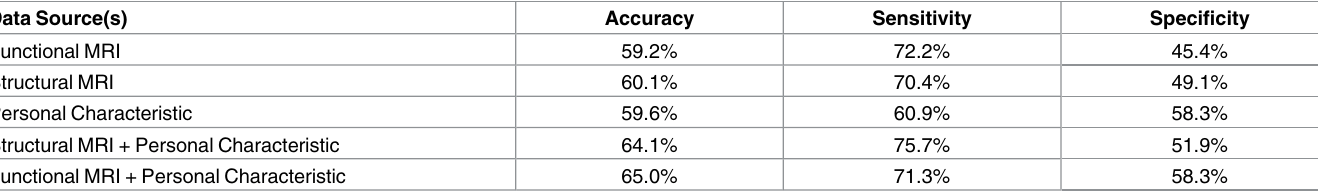
Table 16. ABIDE results summary.